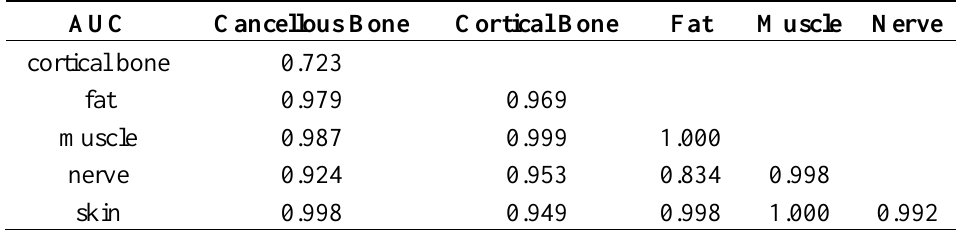
Table 2. Tissue differentiation by AUC.